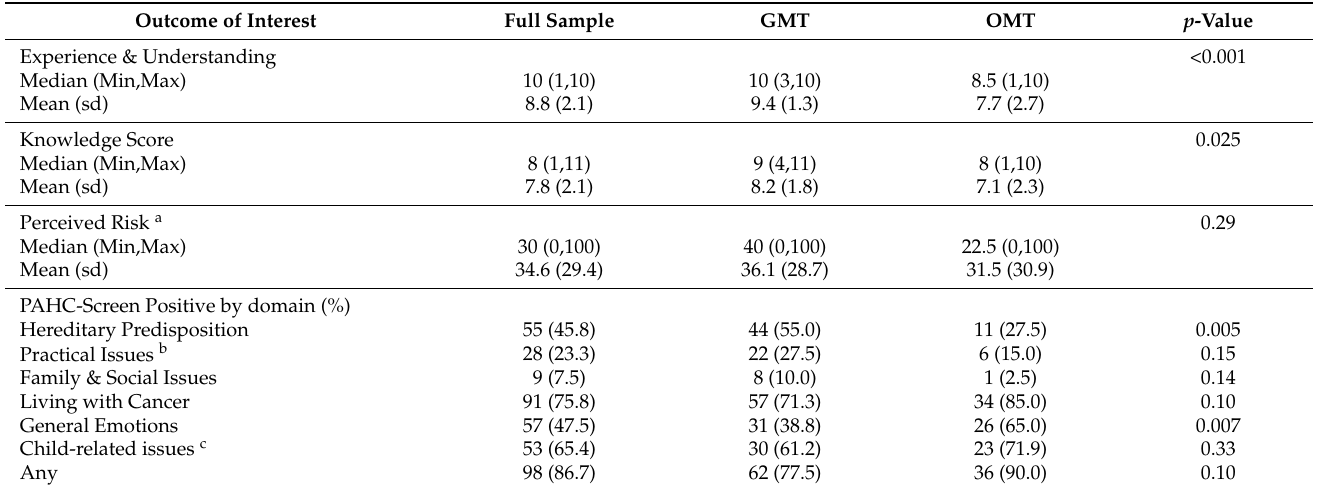
Table 2. Comparison of survey 1 responses in GMT versus OMT